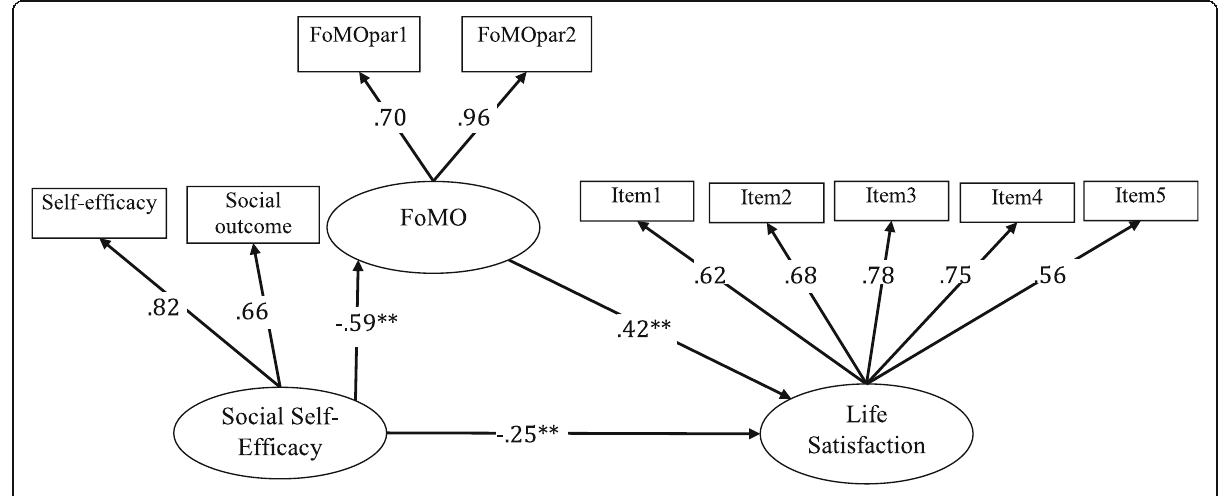
Fig. 2 Mediation for social self-efficacy on life satisfaction via FoMO